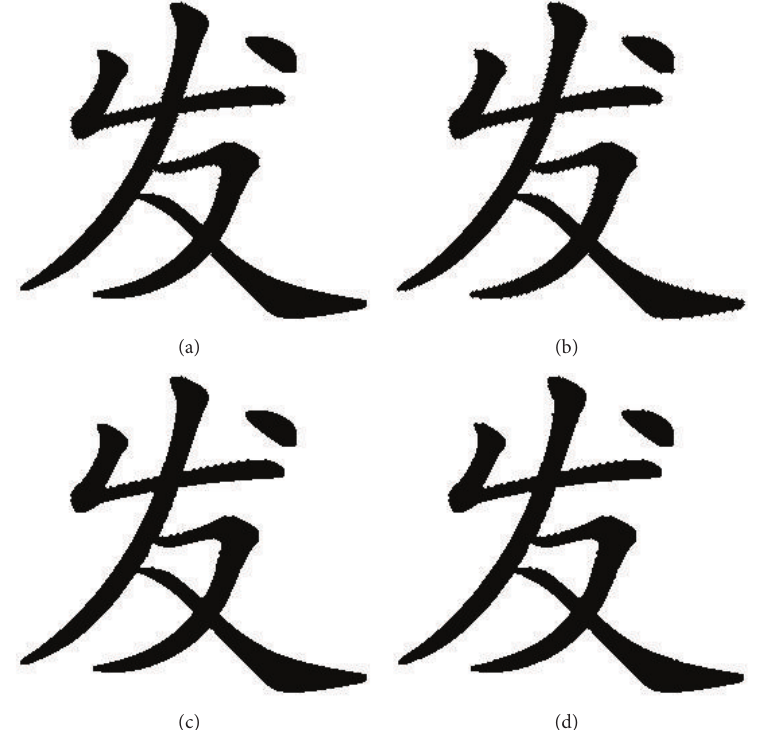
Figure 13: Denoising using the proposed based on gravity center and chaos degree: (a) the font binary image after flipping 900 pixels; (b) the font binary image after flipping 1200 pixels; (c) the font binary image after denoising which flipped 900 pixels; (d) the font binary image after denoising which flipped 1200